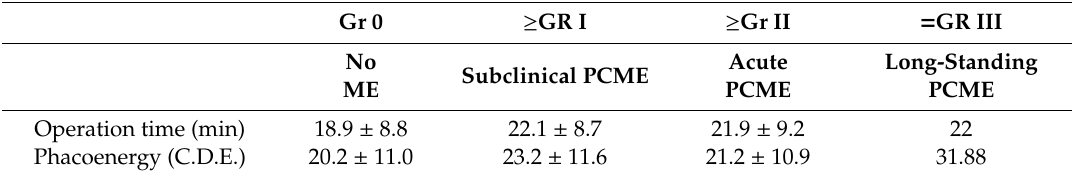
Table 5. Surgical variables according to the PCME